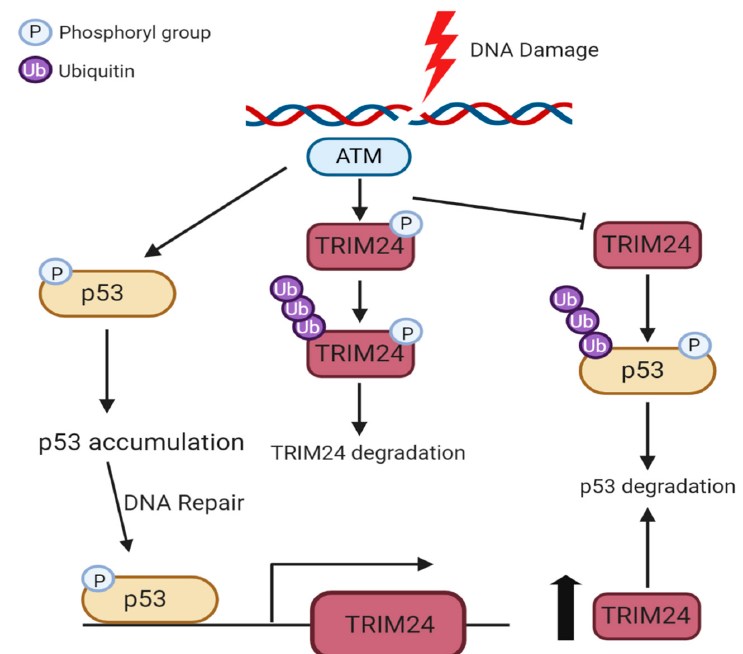
Figure 4. The TRIM24-p53 autoregulatory feedback loop. In response to DNA damage, the ATM kinase is activated, which phosphorylates both p53 and TRIM24. Phosphorylated TRIM24 becomes auto-ubiquitinated via its RING domain and is targeted for proteasomal degradation. p53 is not ubiquitinated by TRIM24 and becomes stabilised. Phosphorylated p53 accumulates and functions to promote DNA repair. Post-DNA damage, phosphorylated p53 can then bind the promoter of TRIM24, activating TRIM24 transcription and increasing its expression. Newly synthesised TRIM24 now selectively targets phosphorylated p53 for degradation in order to bring excess p53 levels back to a normal level, thus completing the negative feedback loop.